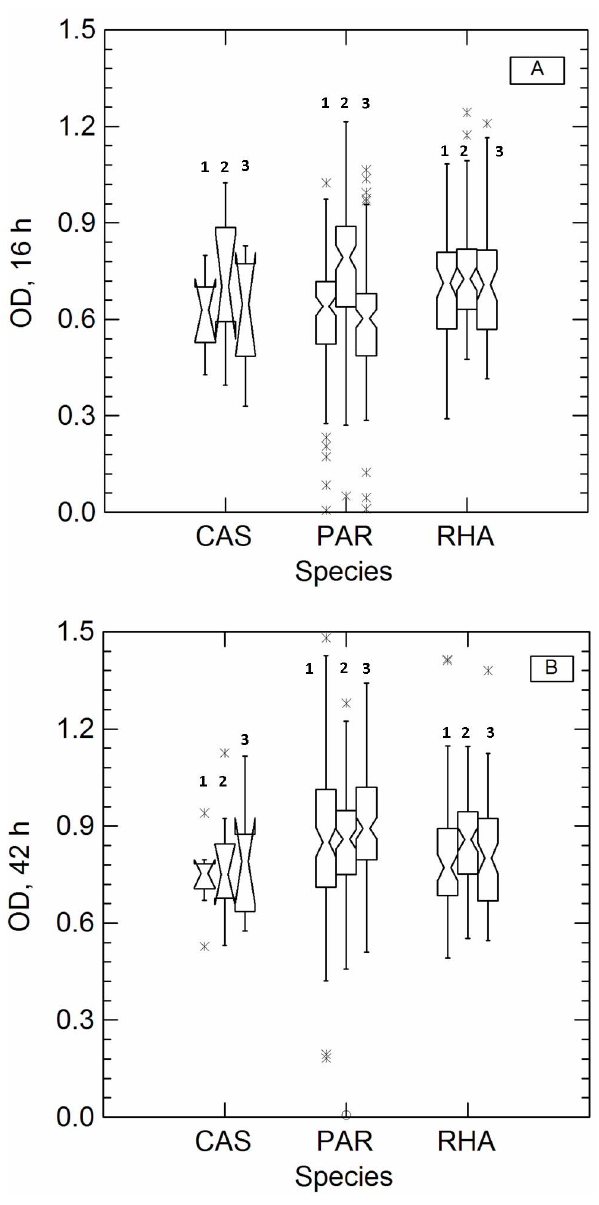
Figure 1. Notched box and whiskers plots showing the distribution of increase in optical density at 450 nm (OD) after 16 (panel A) and 42 (panel B) h of cultivation in anaerobiosis (AN, box 1), aerobiosis (AE, box 2) and heme-supplemented aerobiosis (AEH, box 3). Species: CAS, L. casei ; PAR, L. paracasei ; RHA, L. rhamnosus . The notches indicate the median and its confidence limits; whiskers indicate range of data within 6 1.5 interquartile range; x symbols indicate outlier